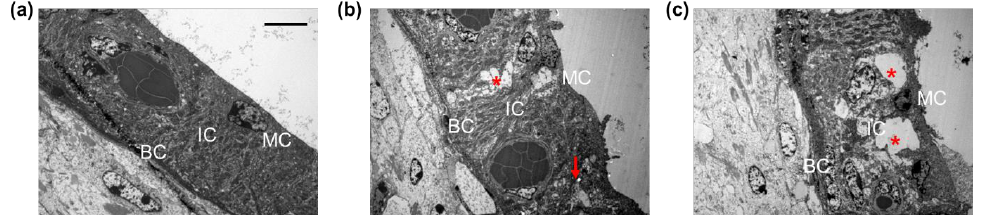
Figure 5. Ultrastructural analysis of stria vascularis before (normal control) and after (14 d) TTS or PTS. ( a ) Normal stria vascularis showed intact three layers of strial cells. ( b ) TTS-treated stria vascularis exerts small vacuolization (asterisk) or gaps (arrow) between the strial cells. ( c ) PTS-induced stria vascularis contained the large vacuolization (asterisk) between the cellular processes of strial cells. Scale bar represents 5 μm. BC, basal cells; IC, intermediate cells; and MC, marginal cells. n = 3.